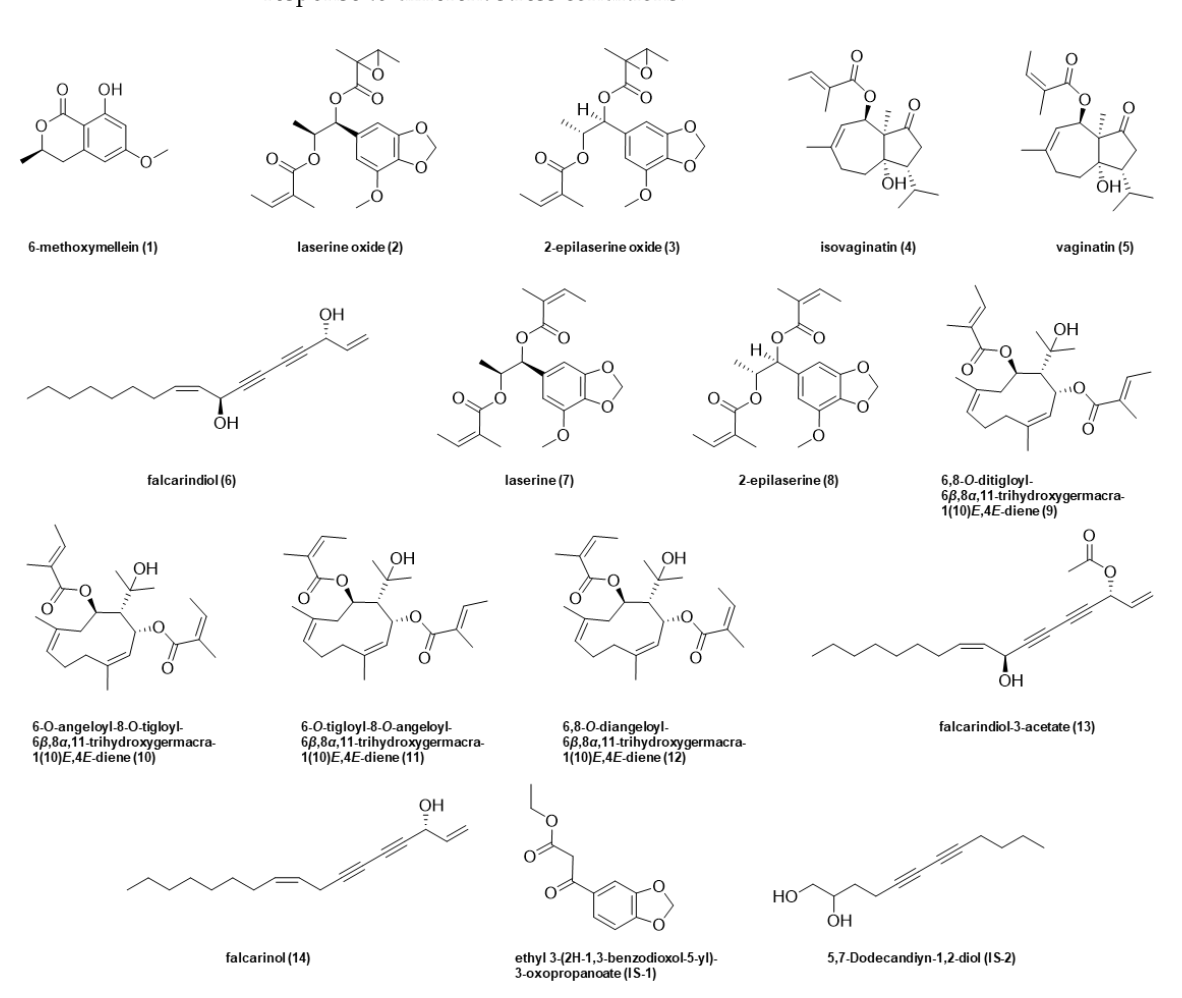
Figure 1. Chemical structure of known bitter compounds 1 – 14 in carrots and internal standards 1 and 2 .